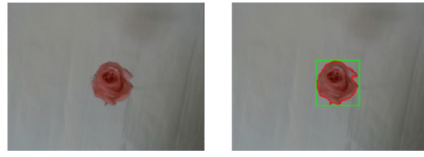
Figure 3. Detection of flower bud region.